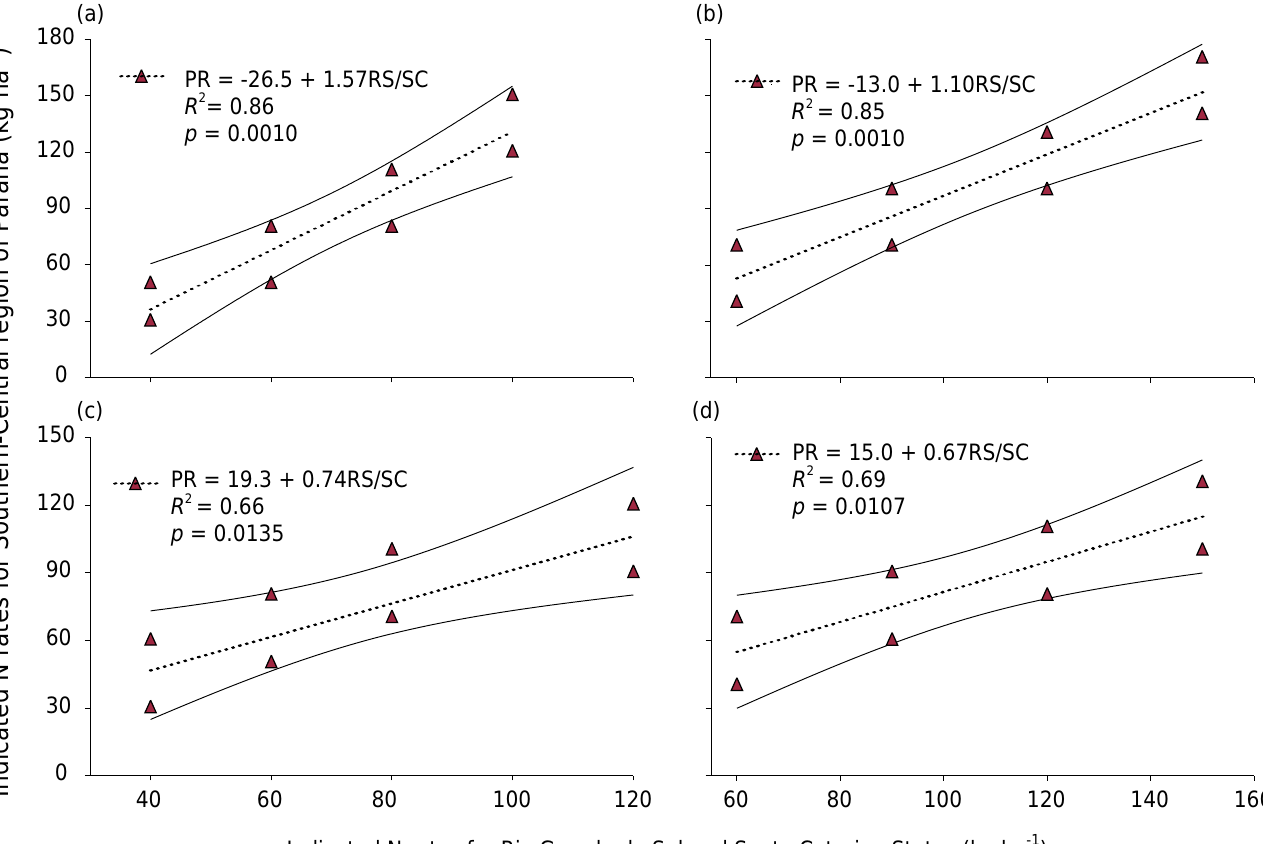
Figure 6. Relationship of indicated urea-N rates for wheat after soybean (a) and after corn (b) and barley after soybean (c) and after corn (d) in Rio Grande do Sul and Santa Catarina (CQFS-RS/SC, 2016), to the proposed N rates for the South-Central region Paraná. Dotted lines represent linear regression curves and solid lines 95 % of the confidence interval.